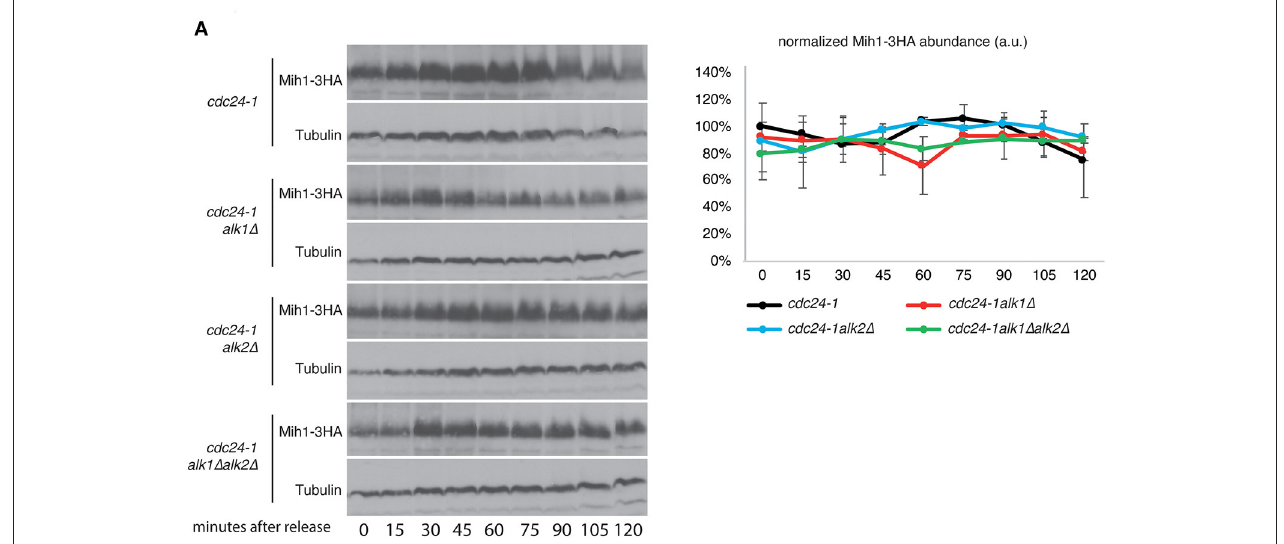
FIGURE 3 | Alk1 does not modulate Mih1 post-translational modifications. (A) Cells of the indicated strains were synchronized in G1 at permissive temperature and held at 37 ◦ C for further 45’ before being released into the cell cycle at restrictive temperature. Samples were taken every 15’ to follow protein levels and modifications by western blot. The graph shows the relative Mih1-3HA abundance normalized on tubulin levels. Error bars represent standard deviation. played by haspin in this pathway, it is not dependent on H3- T3